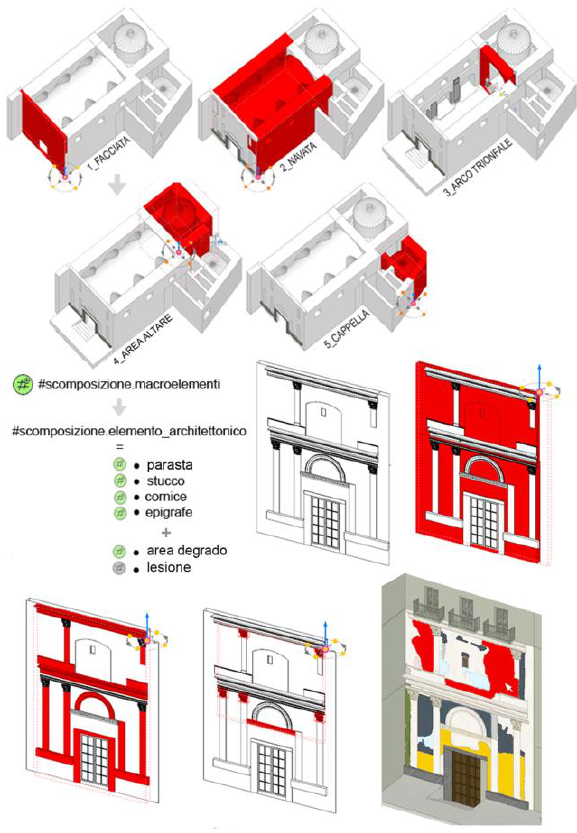
Figure 7 . Semantic decomposition of architectural complex system: from macro-elements to